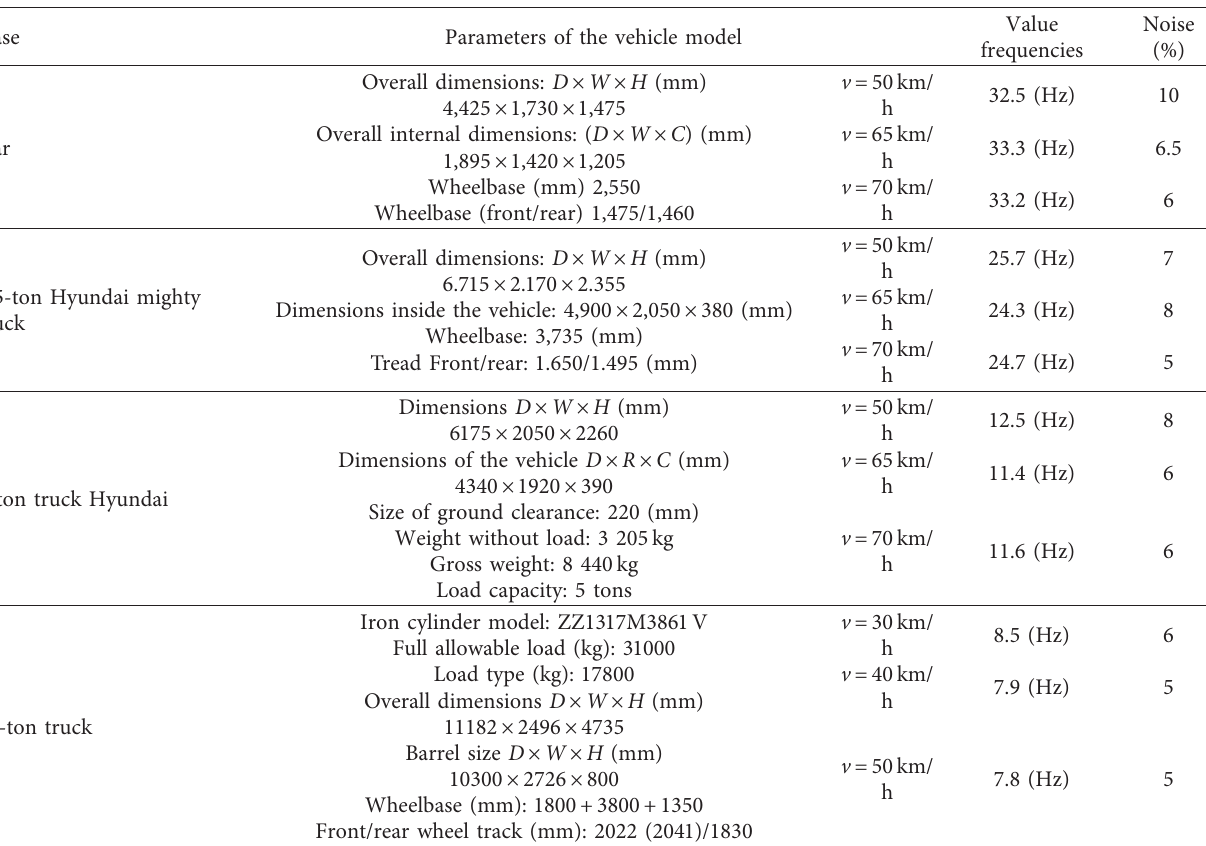
Figure 8: Vibration spectrum of the signal. Table 2: Results of the PSD obtained in different